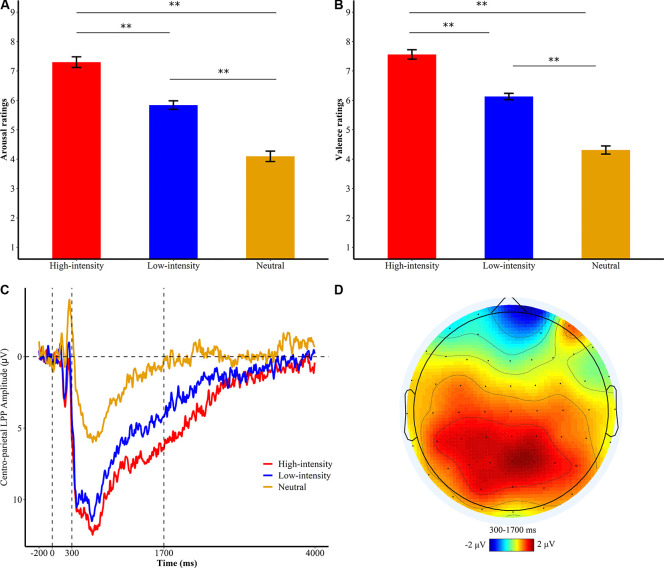
Subjective ratings of (A) emotional arousal and (B) valence of the passive watching group. **p < 0.001; bars represent standard error. (C) Centro-parietal late positive potential (LPP) amplitudes for different levels of emotional intensities of the watching group during the first exposure phase. Waveforms are averaged across CPz and Pz electrodes. The x-axis runs from the beginning of the baseline (−200 ms before picture onset) to the end of the picture presentation (4,000 ms). (D) Topographical distribution of the difference wave of high intensity minus neutral in the watching group.